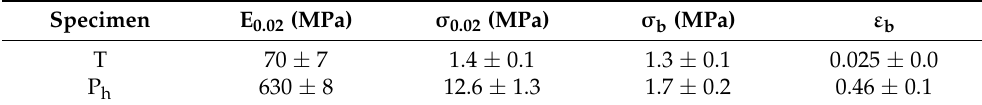
Figure 7. Evaluation of stress relaxation behavior, over time, of the printed specimens after in vitro aging: ( a ) T and ( b ) P h . Table 6. Mean and standard deviation values of the mechanical properties calculated from the stress relaxation tests of the printed specimens after in vitro aging. Specimen